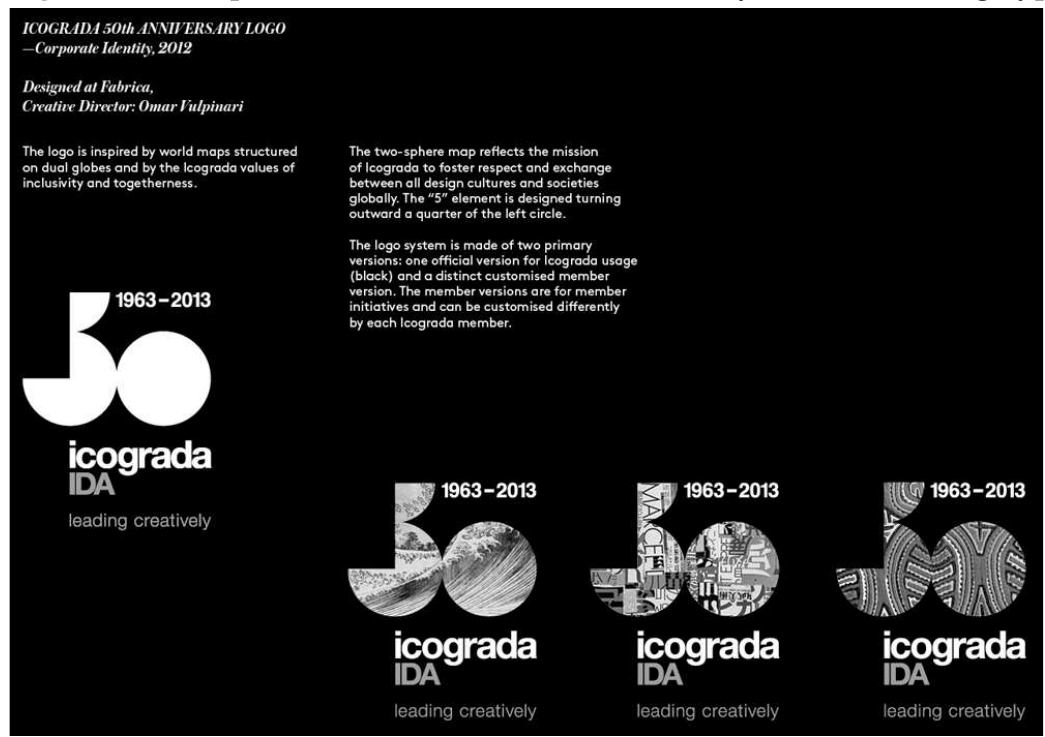
Fig. 9. Omar Vulpinari: ICOGRADA’s 50th Anniversary Emblem and Logotype.